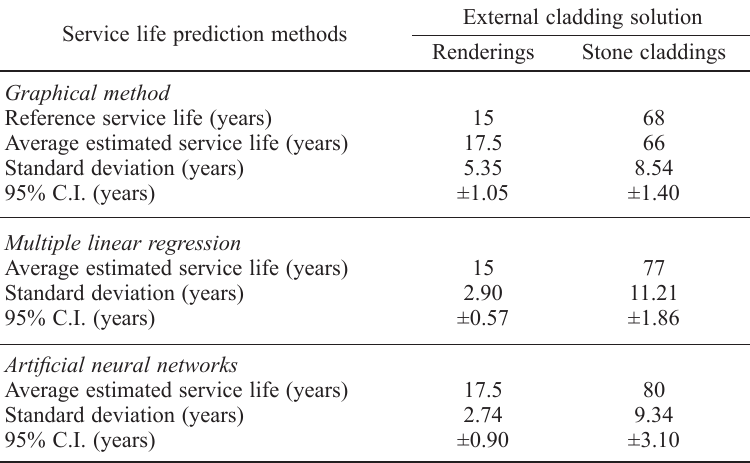
table 2. Summary of the service lives estimated by the various statistical methods Service life prediction